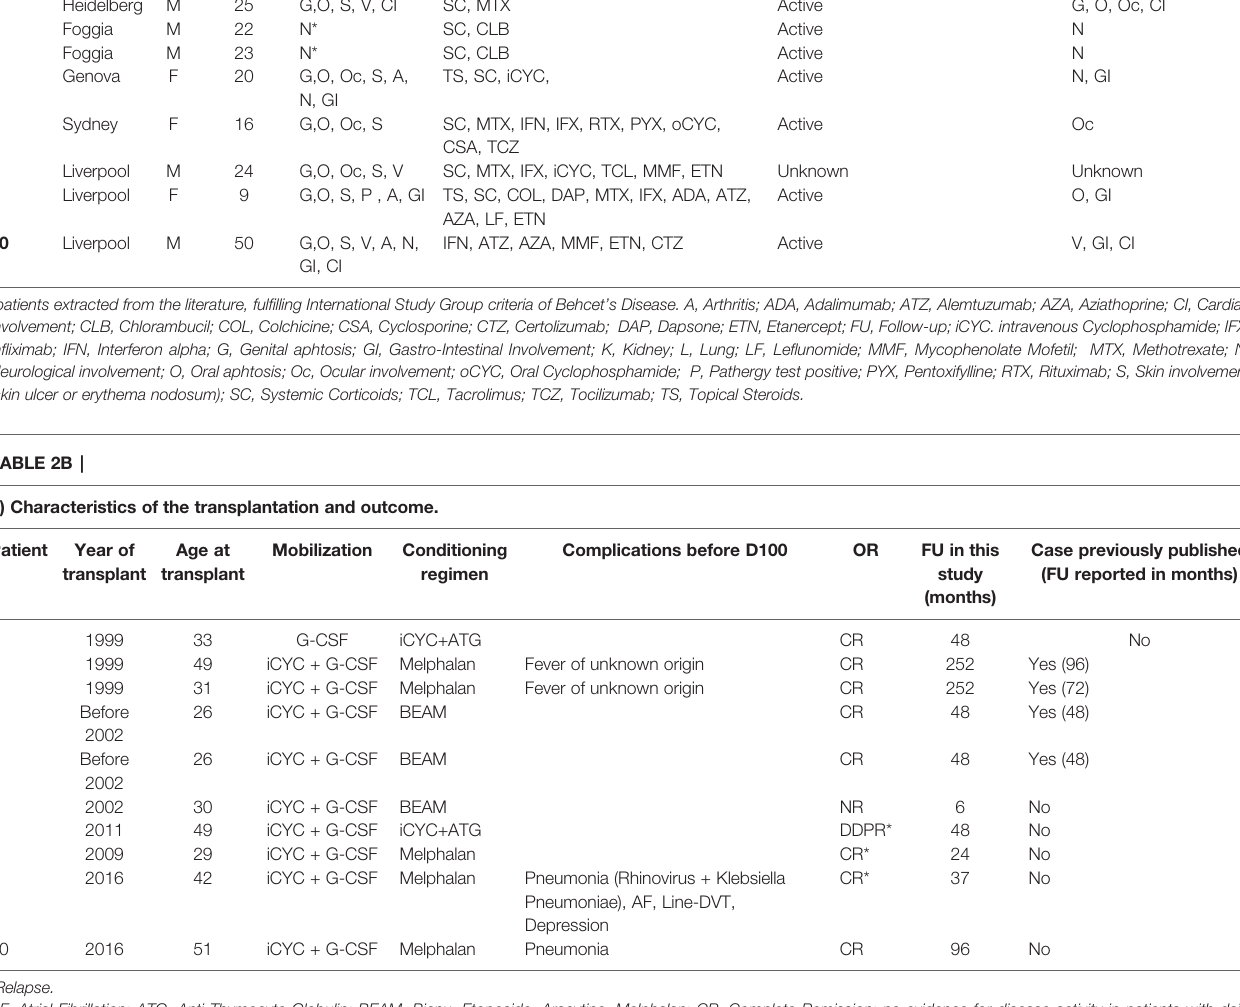
TABLE 2 | Individual characteristics and outcome for patients with Behc ̧ et ’ s disease treated with autologous stem cell transplantation in European Society of Blood and Marrow Transplantation centers (N=10).